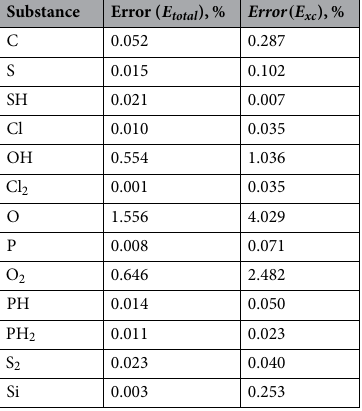
Table 2. Results of testing NN XC functional on a subset of IP13/03 dataset. E total and E xc denote total energy and exchange-correlation energy correspondingly obtained after convergence.